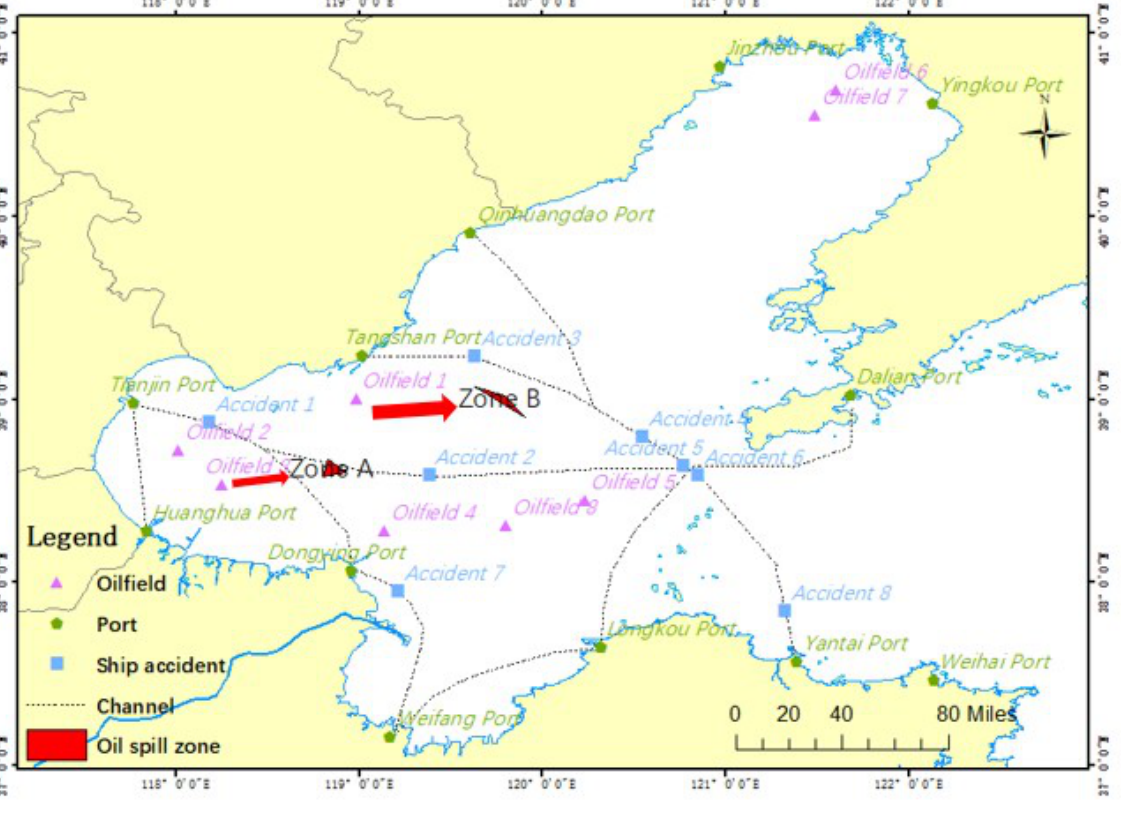
Figure 7. Schematic diagram of the directions of oil spill